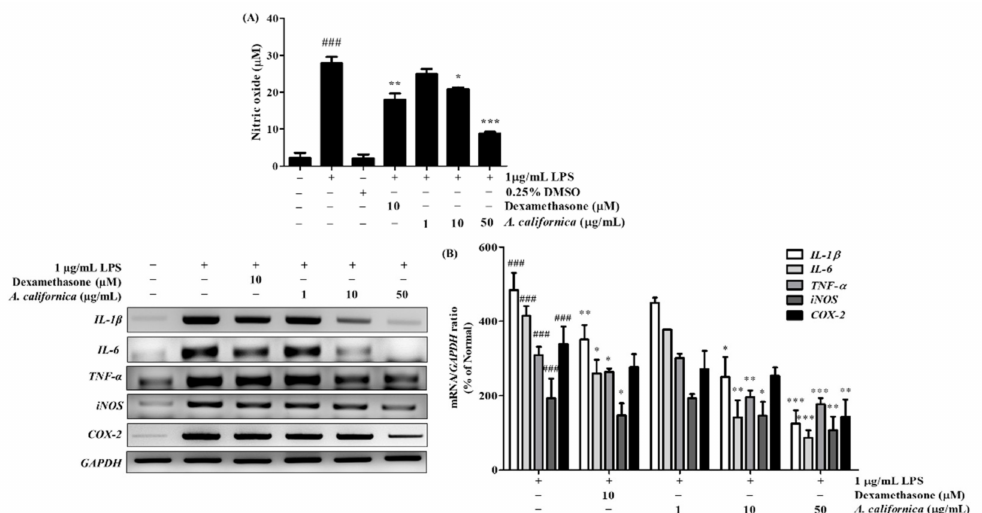
Figure 3. Effect of A. californica extract on NO production ( A ) and mRNA levels of IL-1 β , IL-6, TNF- α , iNOS, and COX-2 ( B ) in LPS-induced Raw264.7 cells. Data are presented as the mean ± SD. # and * indicate significant differences from the non-treated cells and LPS-induced groups, respectively. ### p < 0.001 vs. the non-treated group. *, ** and *** p < 0.05, 0.01, and 0.001 vs. the LPS-induced control,